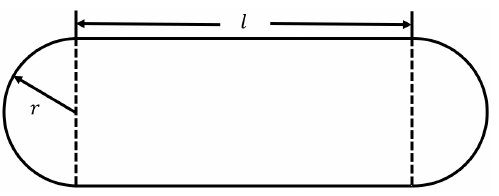
Figure 4. Schematic diagram of the experiment